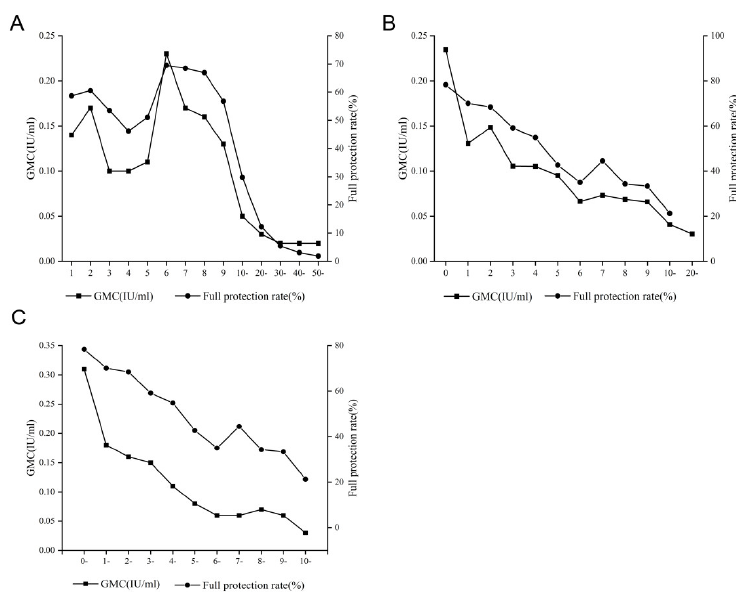
Figure 2. Full protection rate ( ≥ 0.1 IU/mL) and GMC according to age ( A ), interval (years) following basic and booster immunization of TTCVs ( B ), and the interval (years) since the last dose ( C ). Table 1. Seroprevalence and tetanus antibody level according to age.